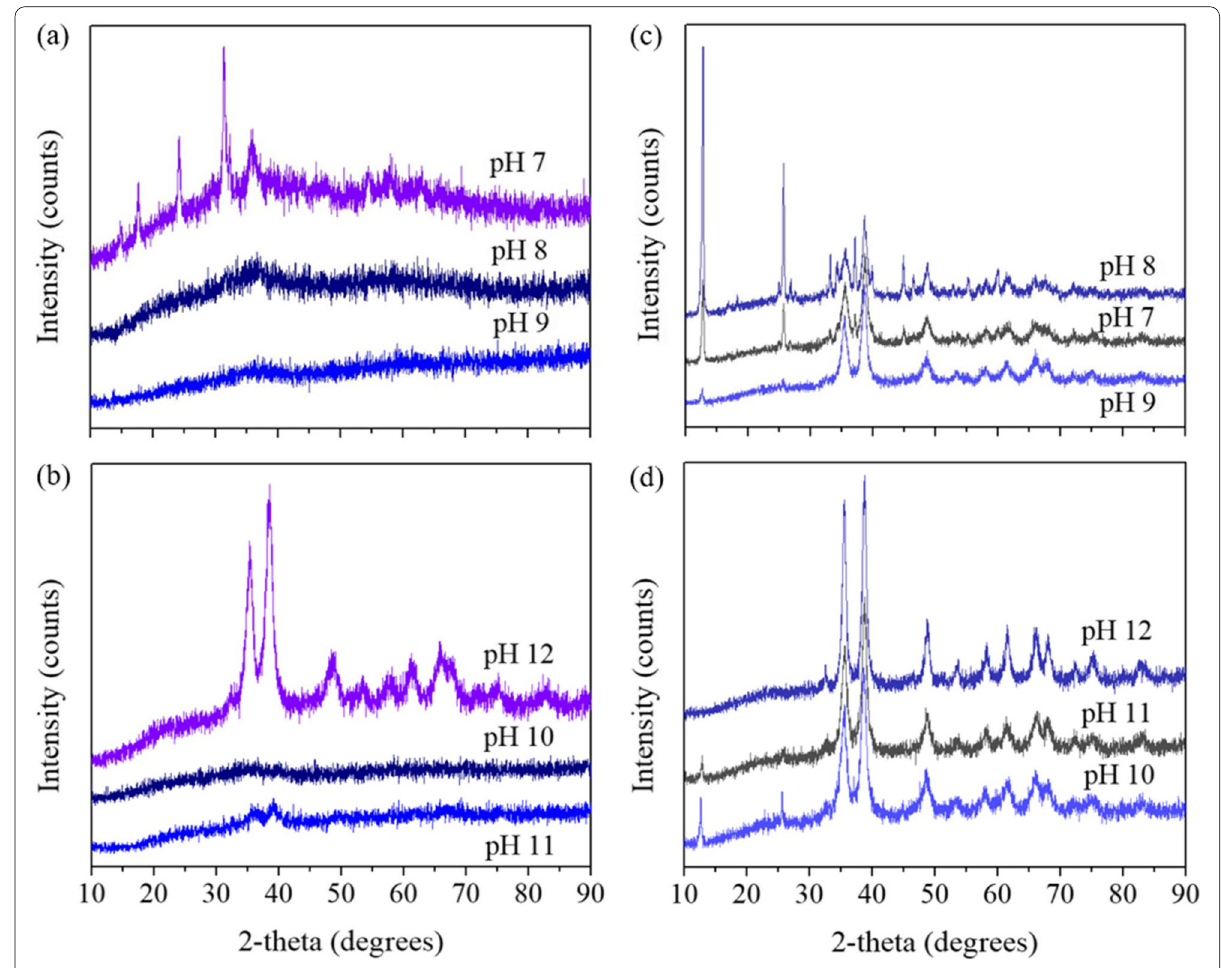
Fig. 7 XRD patterns of ( a , b ) Cu/CO 3 and ( c , d ) Cu/OH